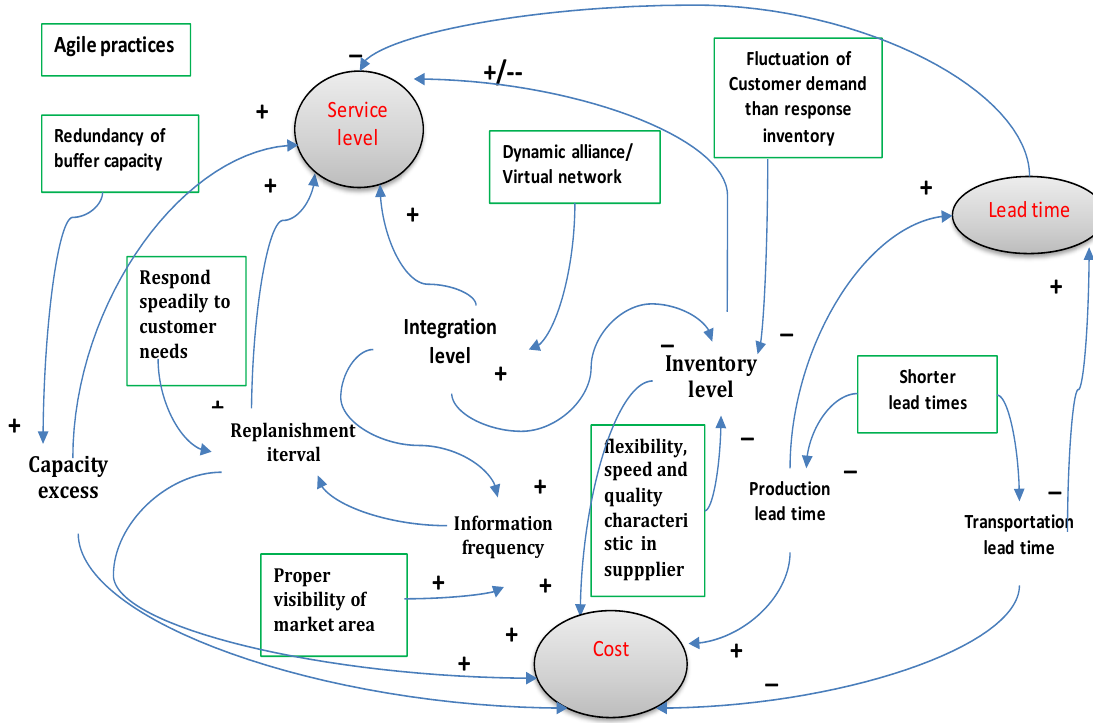
Figure 3: Agile inventory attributes and supply chain performance relationships Figure 3. Agile inventory attributes and supply chain performance